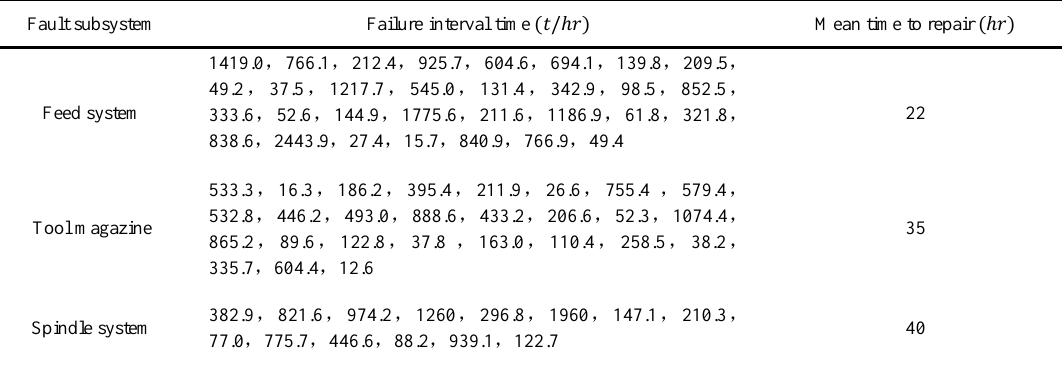
Table 1. Subsystem failure interval time and mean time to repair.